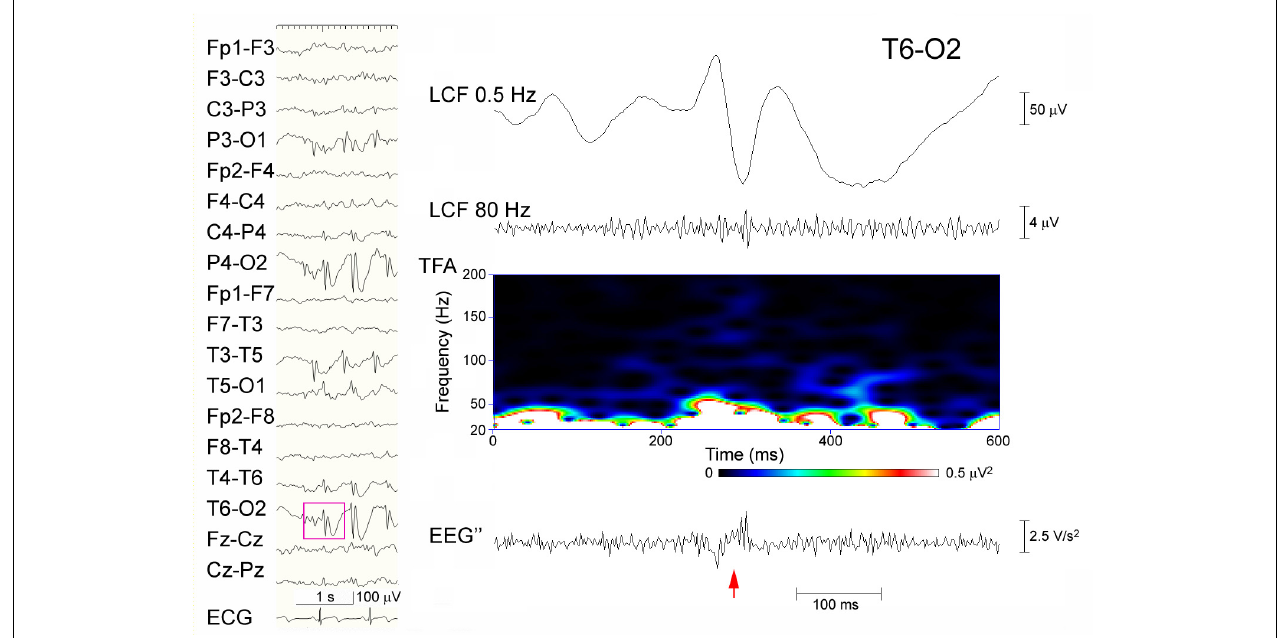
FIGURE 3 | Discordant judgment in an epileptic discharge (possible ripples that were not identified in Session A but identified using the extended criterion in Session B). Spike-waves are dominant over the right occipital region that was recorded from an 8-year-old girl (left panel), and the part of EEG data (pink rectangle) at T6–O2 including the spike (arrow) is temporally expanded and processed (right panel). From the top: filtered at 0.5 Hz; filtered at 80 Hz with background oscillations; time–frequency analysis (TFA) lacking clear spectral blobs; and the EEG (cid:48)(cid:48) trace showing spike-associated oscillations surrounded by noise-like background activity. In Session A, this spike was categorized as devoid of ripples, whereas in Session B, it was judged to include clear ripple oscillations by one reviewer and to include uncertain oscillations by the other.